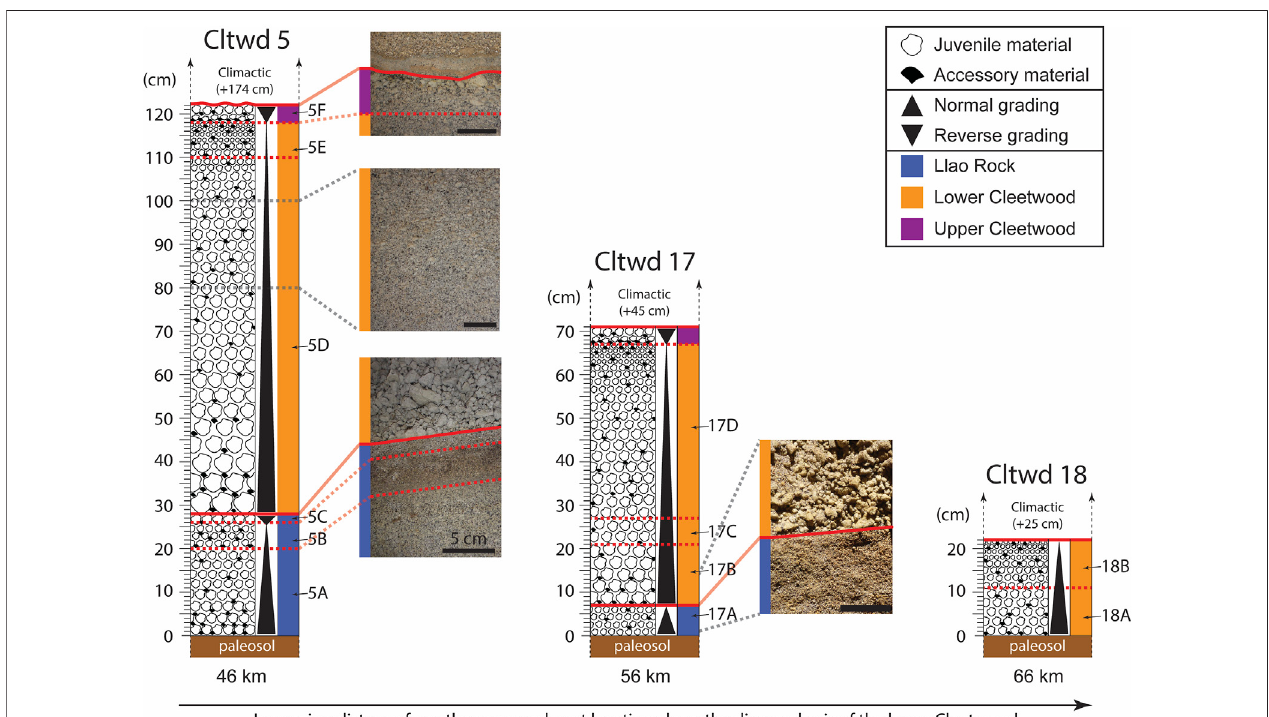
FIGURE 5 | Stratigraphic columns for locations Cltwd 5, 17, and 18, all located on the main dispersion axis of lower Cleetwood and at distances of 46, 56, and 66 km from the proposed vent, respectively (see Figure 3 ). Solid red lines indicate sharp contacts between phases, whereas the dashed red lines divide areas within phases that were subsampled. Scale bar is 5 cm in all photographs. Cltwd 5 exhibits all three phases of the Cleetwood eruption. Llao Rock makes sharp contact with the paleosol, and three distinct subunits (A, B, C) are observed; subunit A (20 cm) normally grades into subunit B (6 cm) which then reversely grades into the uppermostsubunit C (3 cm). LlaoRock and lowerCleetwood make sharp contact and lower Cleetwood (90 cm) is present asa normally graded unit. Upper Cleetwood (4 cm)isreverselygraded,acharacteristicseenatalllocationswhereitisfound.At Cltwd17, allthreephasesarealsoobserved.LlaoRock(7 cm)makessharpcontact with the paleosol but does not exhibit the three distinct subunits seen at Cltwd 5, it is normally graded. Llao Rock and lower Cleetwood make sharp contact with each other, and lower Cleetwood normally grades until upper Cleetwood. At Cltwd 18 , only lower Cleetwood (22 cm) is present and found as one normally graded unit that makes sharp contact with the paleosol at its base. At these three locations, the Cleetwood fall deposit is overlayed by 25 – 174 cm of climactic fall deposit.